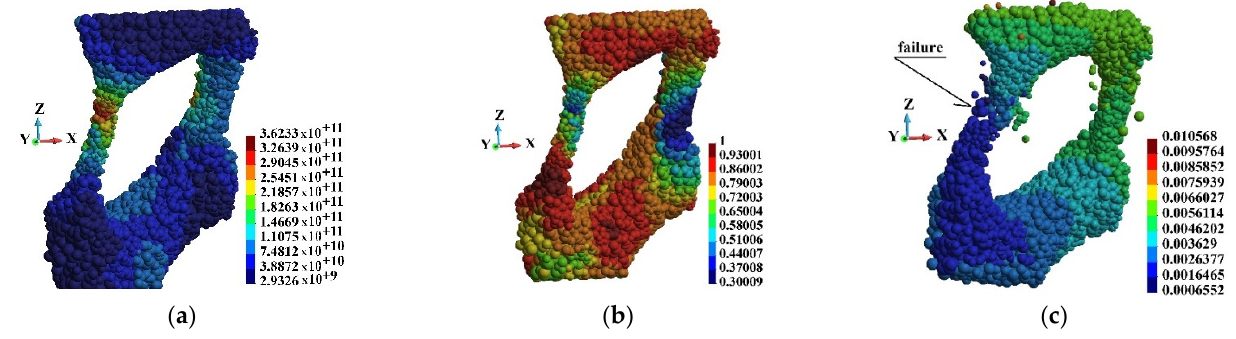
Figure 20. Region o1: ( a ) Mises stress distribution (Pa); ( b ) damage distribution; ( c ) displacements (m) in deformed configuration, scale factor 0.2.